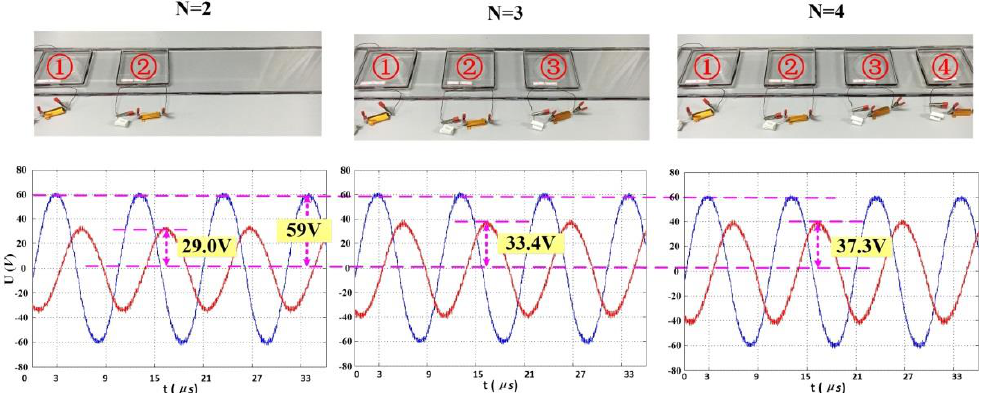
Figure 10. Voltages of source and load ① for different numbers of EVs.